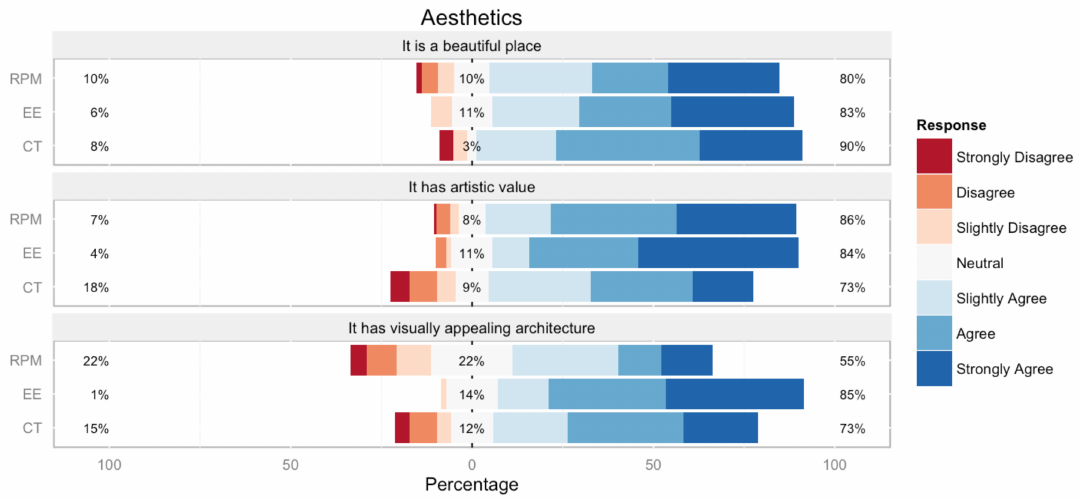
Figure 11. Summary statistics of attitudinal questions regarding Aesthetics among the three locations (By